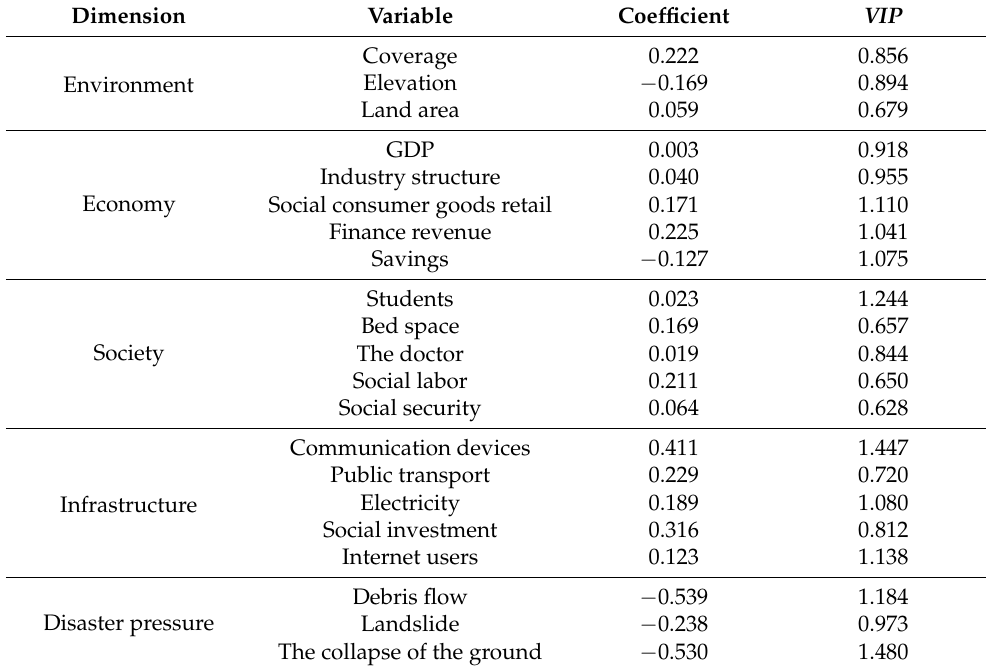
Table 4. PLS regression